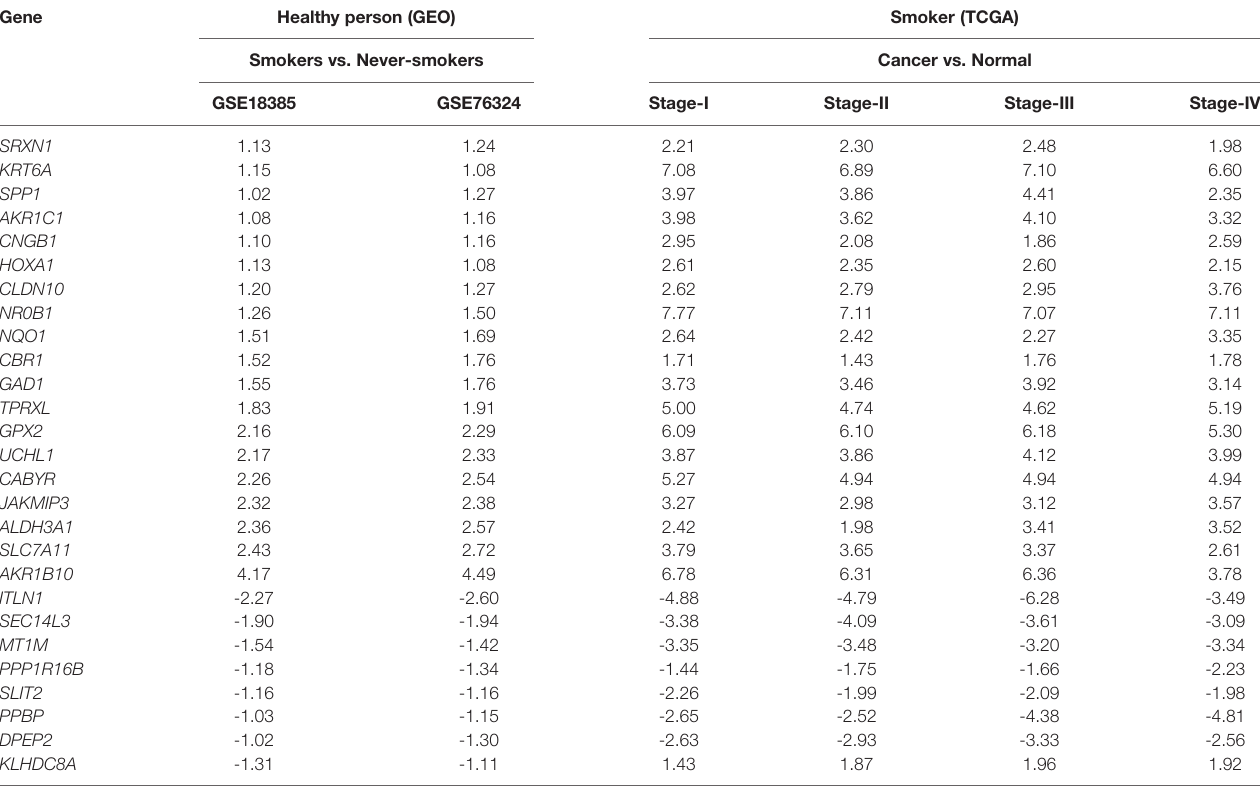
TABLE 2 | Differential expression levels of 27 hub smoking-related genes between healthy smokers and those with lung cancer. Gene Healthy person